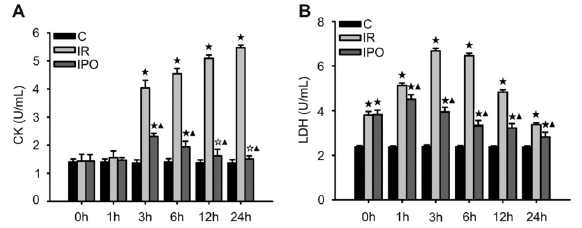
Figure 3. Leakage of necroenzyme creatine kinase (CK) and lactate dehydrogenase (LDH) after skeletal muscle ischemia- reperfusion (IR) injury of 3 h of ischemia and 24 h of reperfusion (n=36). A , Serum CK activity. B , Serum LDH activity. Data are reported as means±SD. q P , 0.05, w P , 0.01 vs sham-operated control group (C); m P , 0.01 vs IR group (one-way ANOVA).